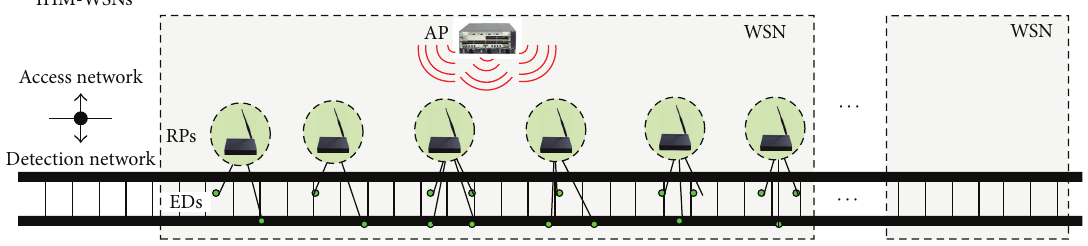
Figure 2: IHM-WSNs architecture for HSR.